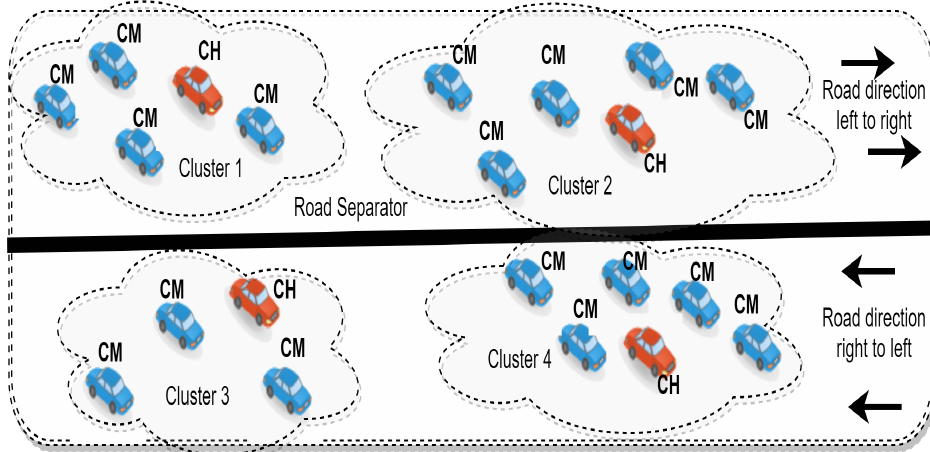
Figure 15. Clustering in PDMAC in the bidirectional traffic scenario